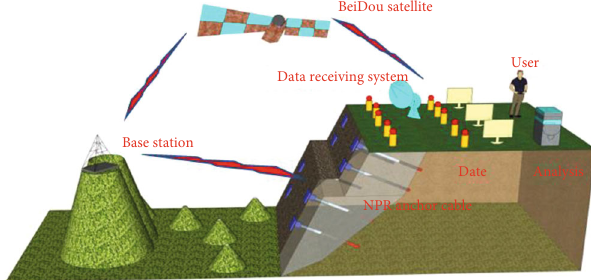
Figure 13: The principle of system operation.